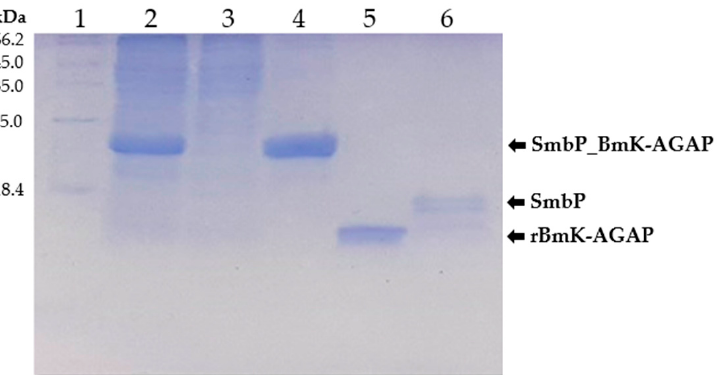
Figure 3. Tricine SDS-PAGE (15%) analysis of SmbP_BmK-AGAP and rBmK-AGAP purification. Lane 1: protein marker; Lane 2: cell lysate; Lane 3: flowthrough; Lane 4: SmbP_BmK-AGAP after IMAC purification; Lane 5: rBmK-AGAP after enterokinase digestion and a second round of IMAC (calculated molecular weight: 7.54 kDa); Lane 6: free SmbP after enterokinase digestion (calculated molecular weight 10.7 kDa).